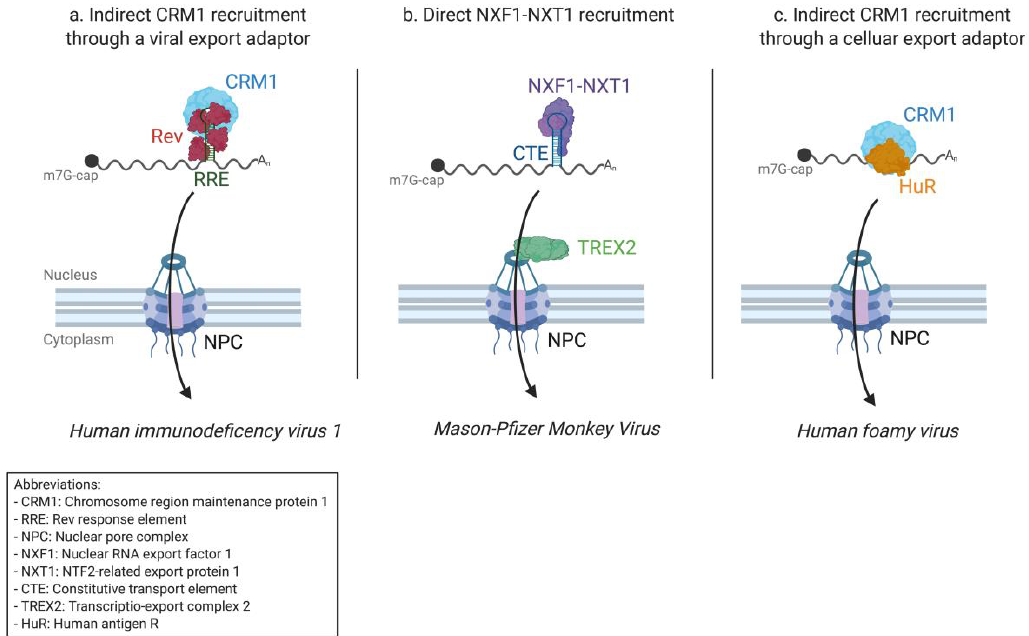
Figure 2. Examples of the mRNA nuclear export mechanisms of retroviruses. ( a ) The export of HIV-1 intron-containing mRNAs occurs via the indirect recruitment of Chromosome region maintenance 1 (CRM1) to the structured Rev responsive element (RRE) RNA element through the multimerized viral Rev protein. ( b ) Mason–Pfizer Monkey Virus intron-containing RNAs are exported through the